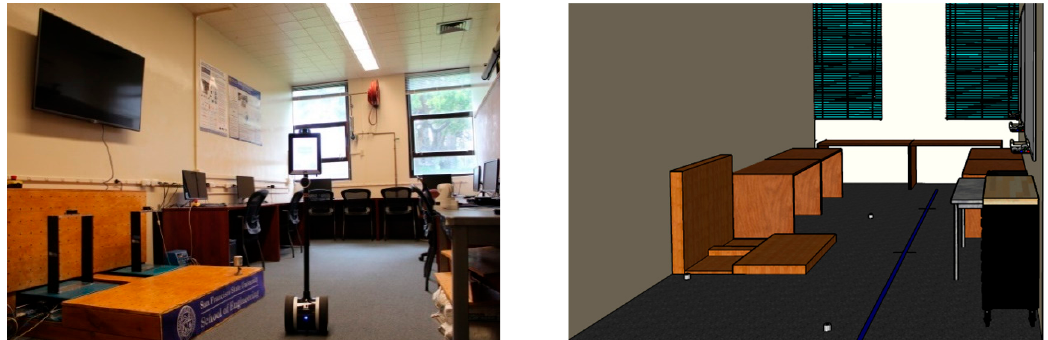
Figure 2. Intelligent structural hazard mitigation laboratory (iSHM) Lab at the San Francisco State University (Left: Picture; Right: 3D Model).